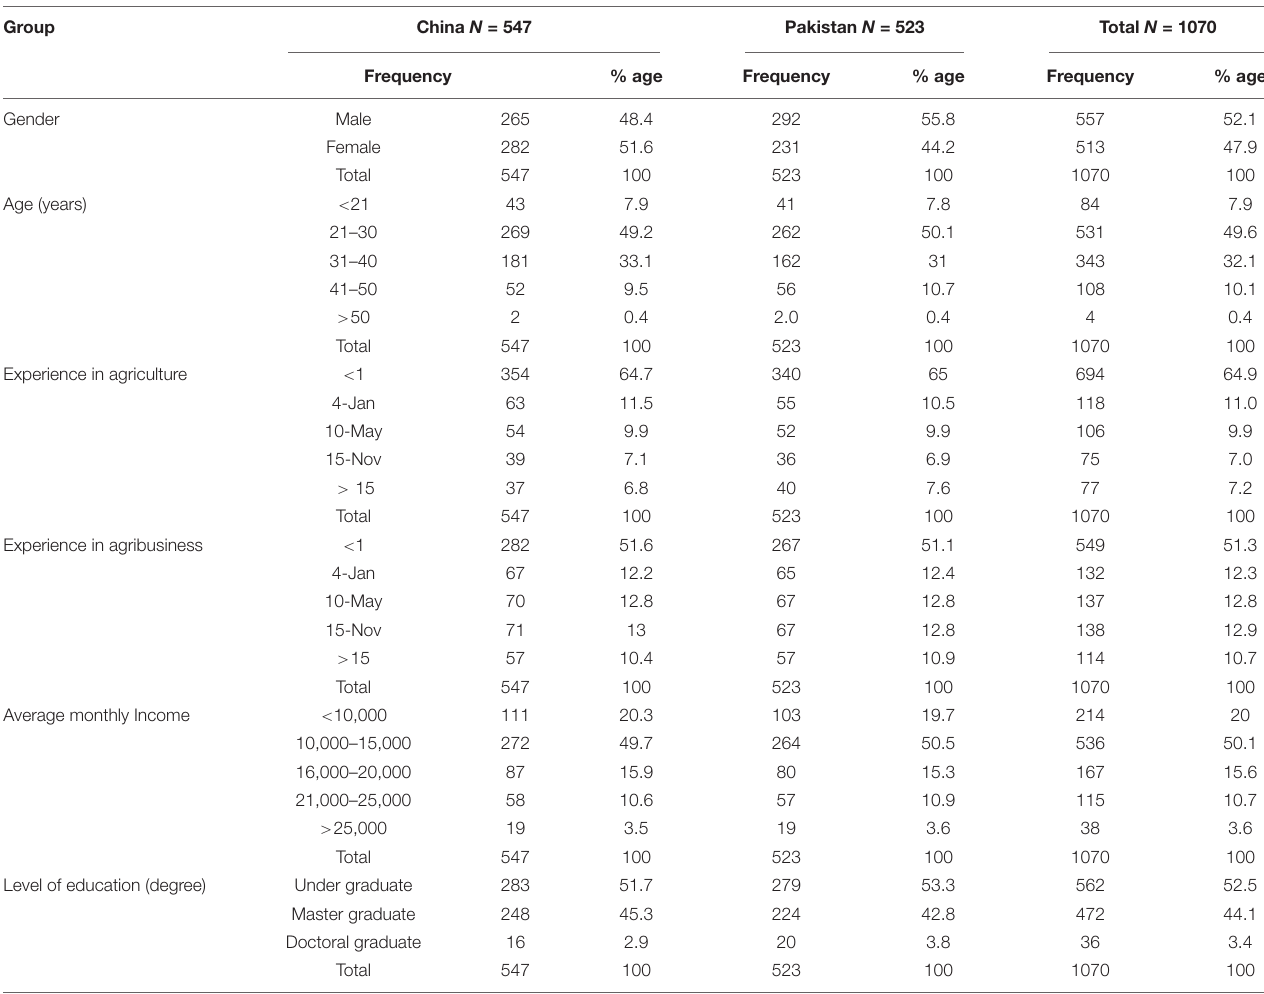
TABLE 1 | Demographic profiles of aspirant entrepreneurs from China vs. Pakistan. Group